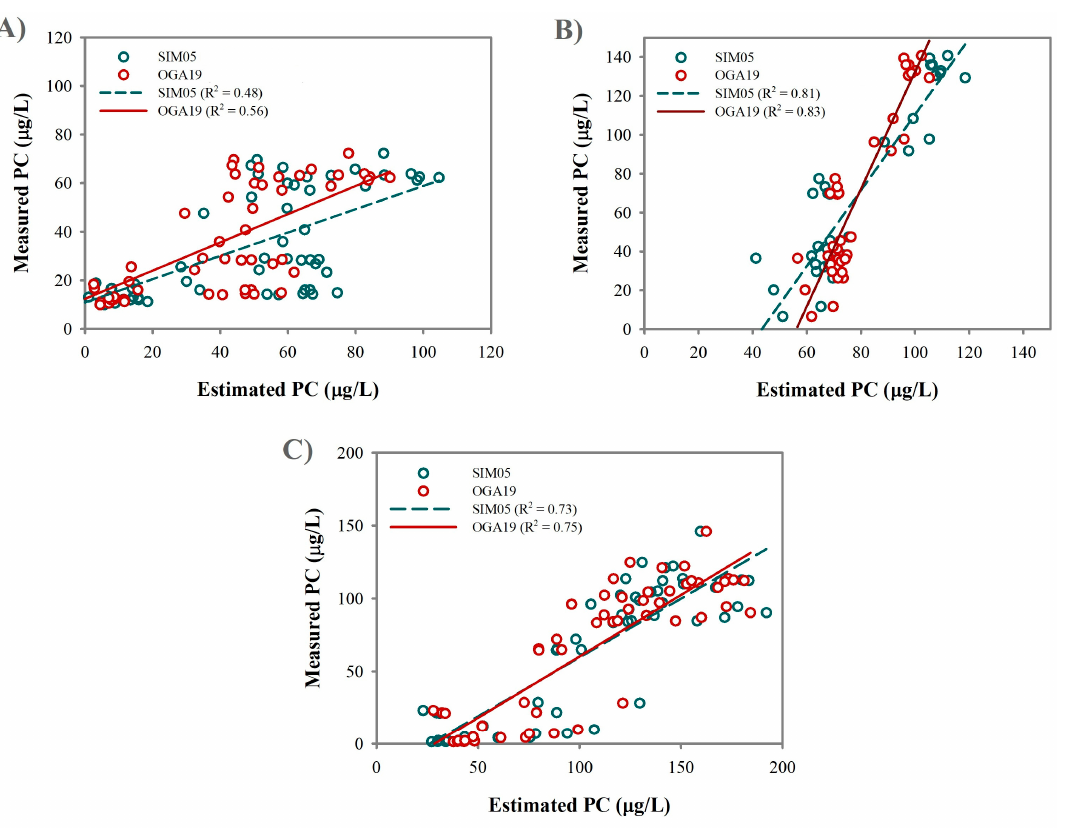
Figure 6. Validation results for SIM05 and OGA19 using the 2010 datasets of ECR ( A ), GR ( B ), and MR ( C ). Table 6. Comparison of error metrics between SIM05 and OGA19.